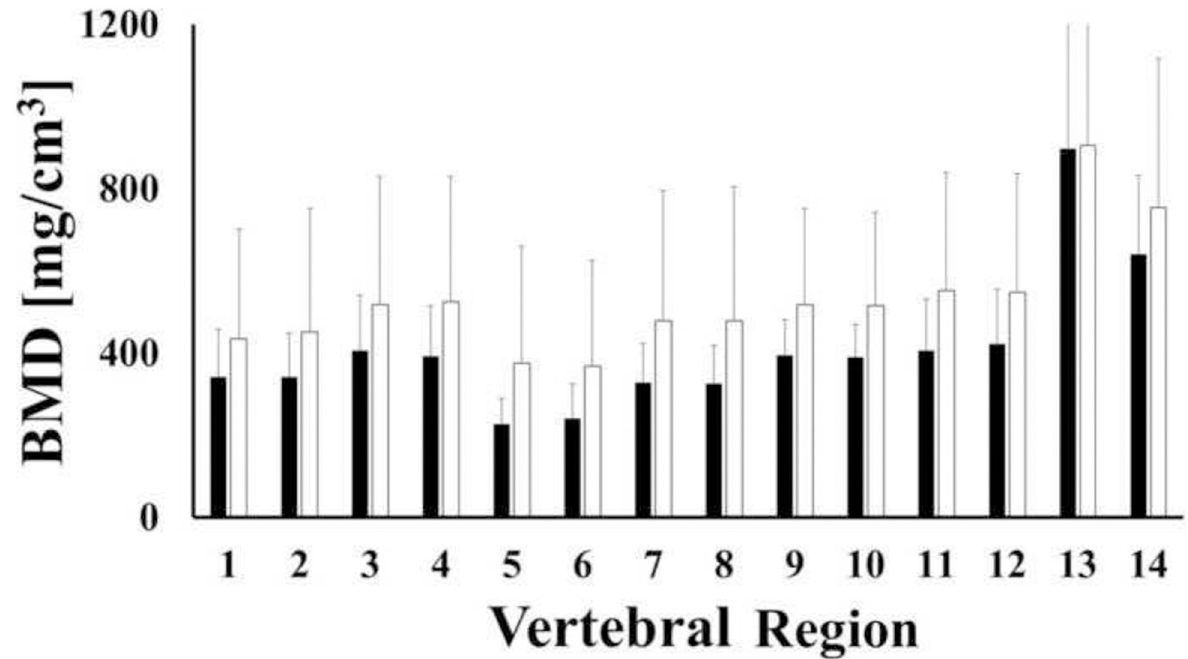
Fig 6. Mean values of bone mineral density across regions of C2 for female (white) and male (black) samples. Bars indicate one standard deviation.